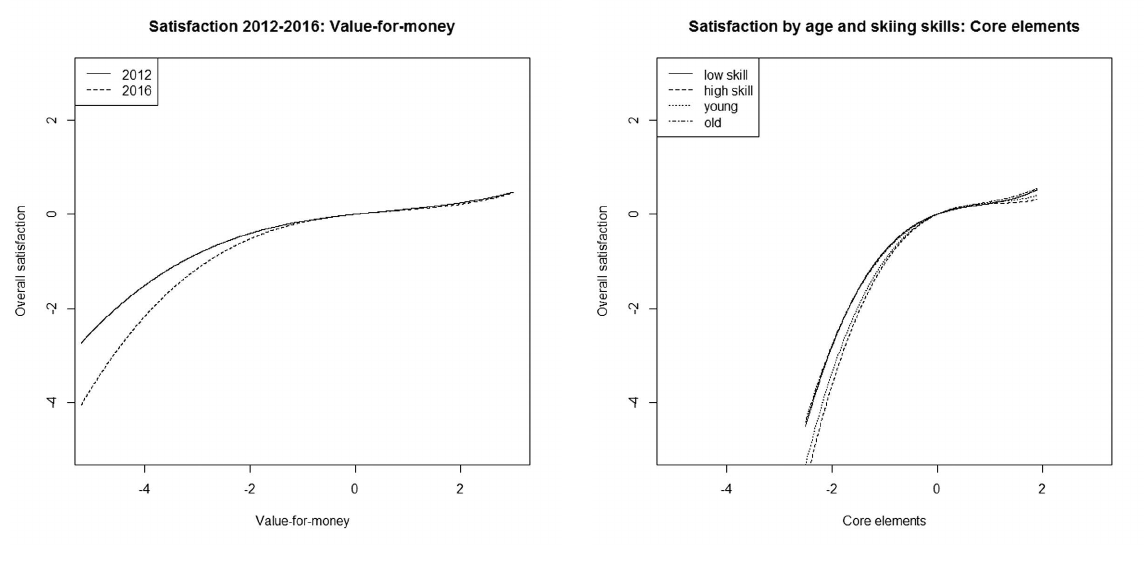
Figure 4. Value-for-Money factor Figure 5. Ski Core in two age and skiing skill